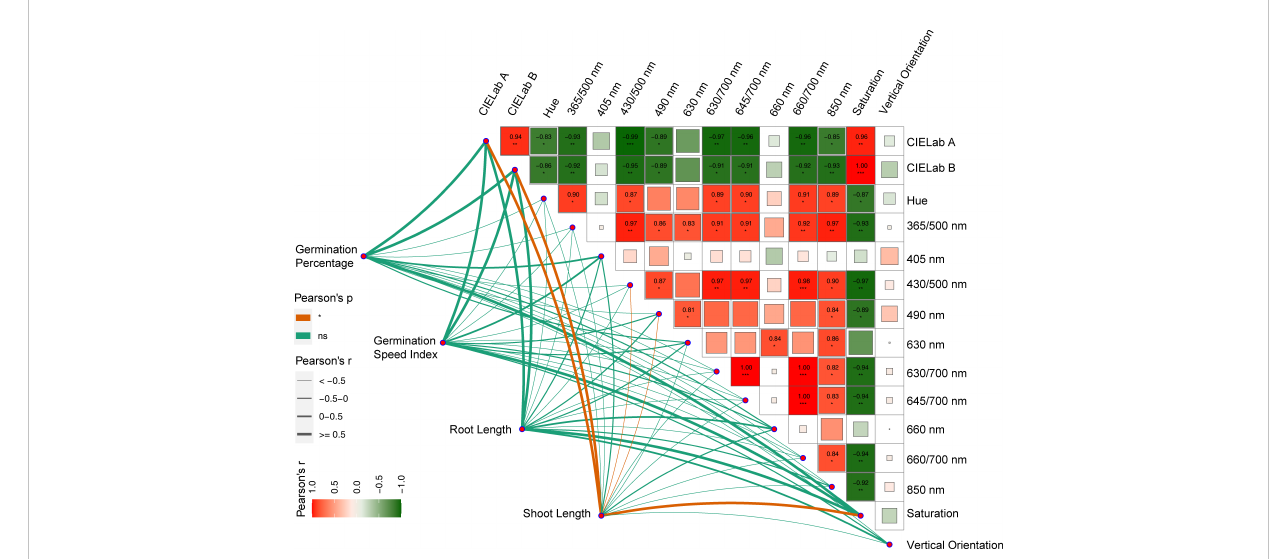
FIGURE 10 Pearson correlation coef fi cient of features based on the fusion of the three feature selection methods and Pearson correlation of germination indicators. The symbols '*', '**' and '***', indicate statistically signi fi cant correlation at P<0.05, P<0.01 and P<0.001 respectively, and ns indicates no correlation at